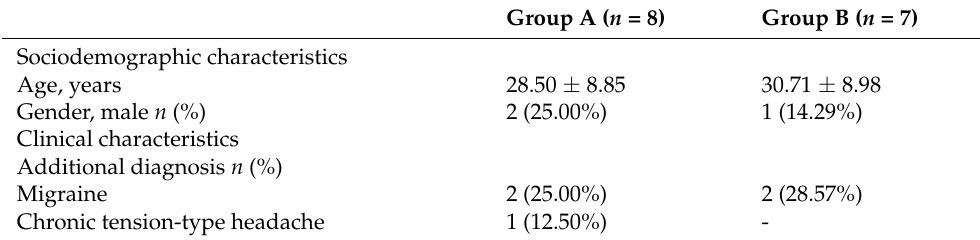
Table 1. Baseline sociodemographic and clinical characteristics.